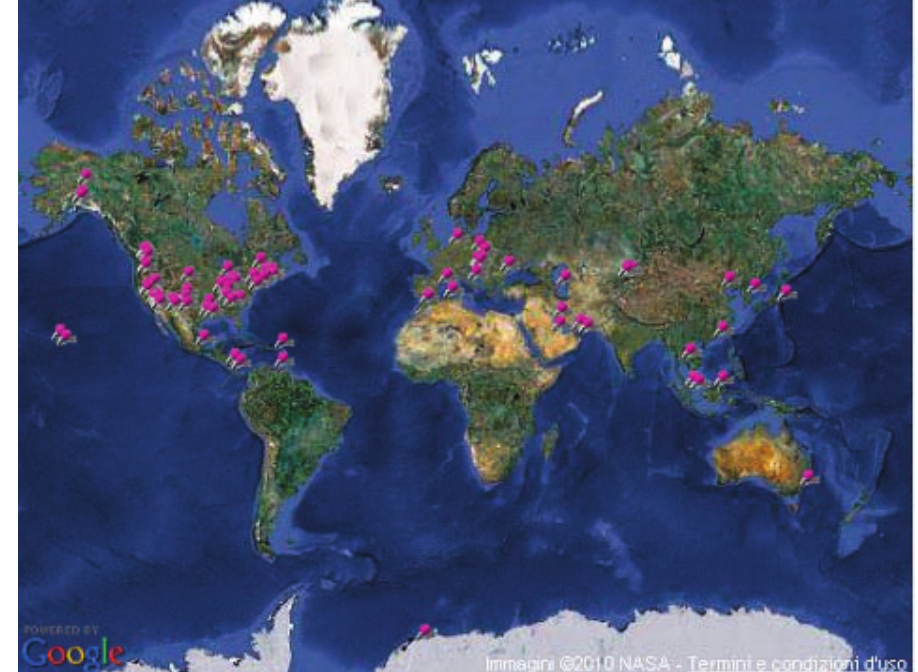
Figure 1. Antelope distribution (status: